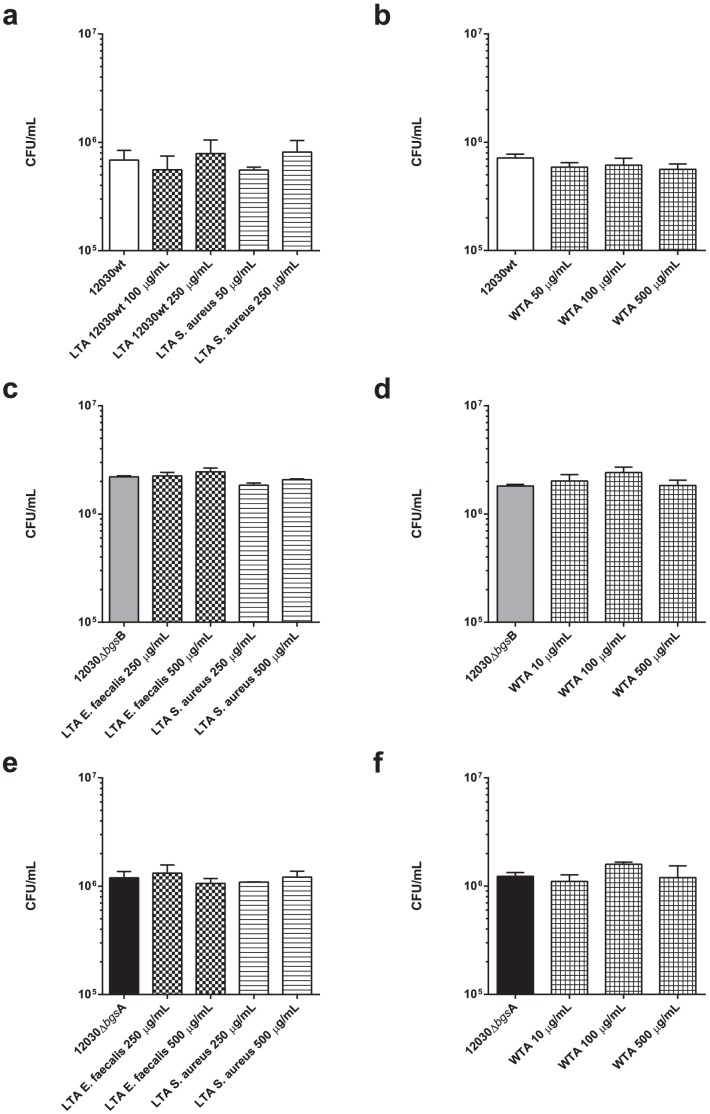
Inhibition of bacterial binding to T24 epithelial cells using WTA and LTA.Epithelial cells were incubated with different concentrations of WTA (A) and LTA (B) 30 min before addition of E. faecalis strains. E. faecalis 12030 wild-type (white bar), E. faecalis 12030ΔbgsB mutant (grey bar), E. faecalis 12030ΔbgsA mutant (black bar). Concentrations of WTA were between 50 and 1000 µg/mL, and concentrations of LTA were between 100 and 250 µg/mL for the prepared LTA and between 50 and 250 µg/mL for the LTA purchased from Sigma. In both cases, bacterial binding to T24 cells was not significantly impaired when using LTA and WTA. Using ANOVA test the difference was statistically not significant (p>0.05). Bars represent average ± S.E.